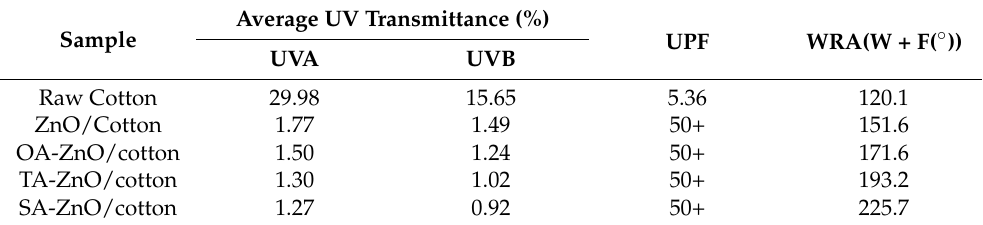
Table 1. UV and wrinkle resistance of the Raw Cotton, ZnO/Cotton, SA-ZnO/Cotton, OA- ZnO/cotton, and